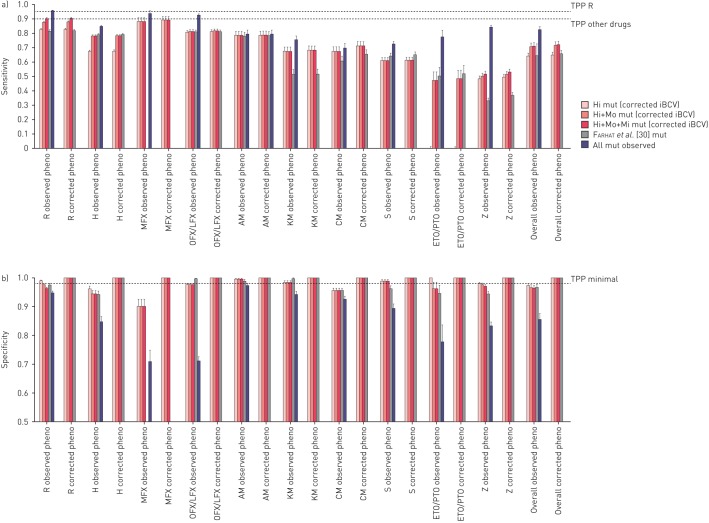
Comparison of the sensitivity and specificity of different groups of mutations. For each drug, two types of comparison were performed. First, the a) sensitivities and b) specificities were calculated with the associated 95% confidence levels for the “observed” phenotypic result. Specifically, the figures for high (Hi), high and moderate (Hi+Mo) and high and moderate and minimal (Hi+Mo+Mi) confidence interpretative best confidence values (iBCVs) were compared with using all mutations observed in the study. Moreover, genetic variants were included from a recent study by Farhat
et al. [30]. Second, we conducted the same comparison using a “corrected” phenotype as reference (i.e. where we assumed that strains that were phenotypically susceptible but harboured either a Hi, Hi+Mo or H+Mo+Mi confidence iBCV mutation or mutations by Farhat
et al. were false-susceptible results). For some drugs, such as capreomycin (CM), both percentages remained unchanged as all mutations were high confidence. Minimal target product profile (TPP) thresholds set by the World Health Organization for new molecular-based diagnostic tools compared to phenotypic drug susceptibility testing [31] are shown. These were intended for rifampicin (R), isoniazid (H), fluoroquinolones, kanamycin (KM), amikacin (AM) and CM only. However, in addition we included the threshold for the remaining drugs and overall results for comparison (for additional details see online supplementary material 11). MFX: moxifloxacin; OFX: ofloxacin; LFX: levofloxacin; S: streptomycin; ETO/PTO: ethionamide and prothionamide; Z: pyrazinamide.